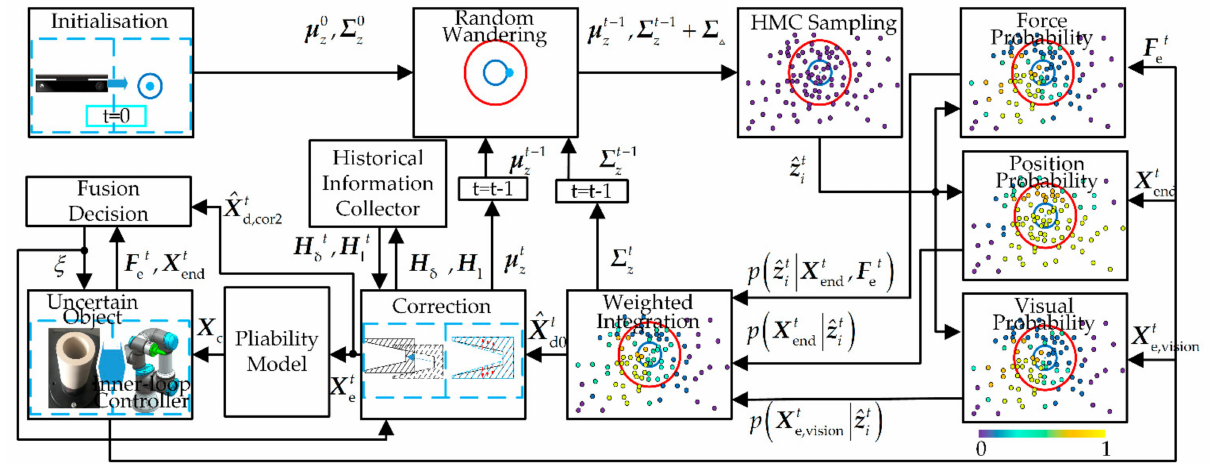
Figure 2. Multi-sensor perception